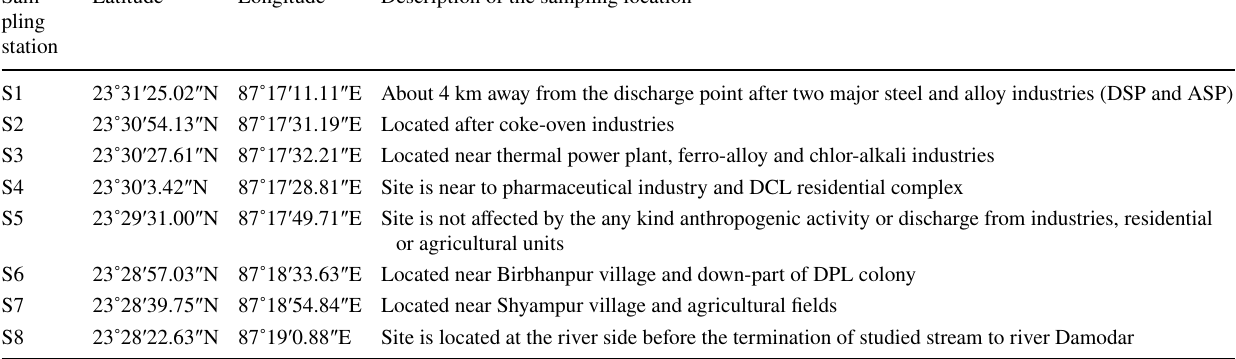
Table 1 Description of the sampling sites Latitude Longitude Description of the sampling Sam- pling station